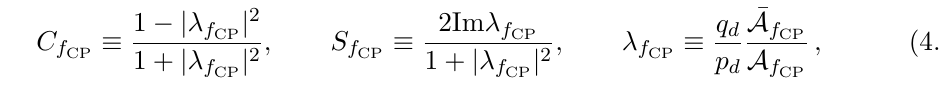
of the B 0 → π + π − measurement at Tera- Z , leaving room for more optimistic assumptions. The performance of B + → π + π 0 is anticipated to be between B 0 → π 0 π 0 and B 0 → π + π −